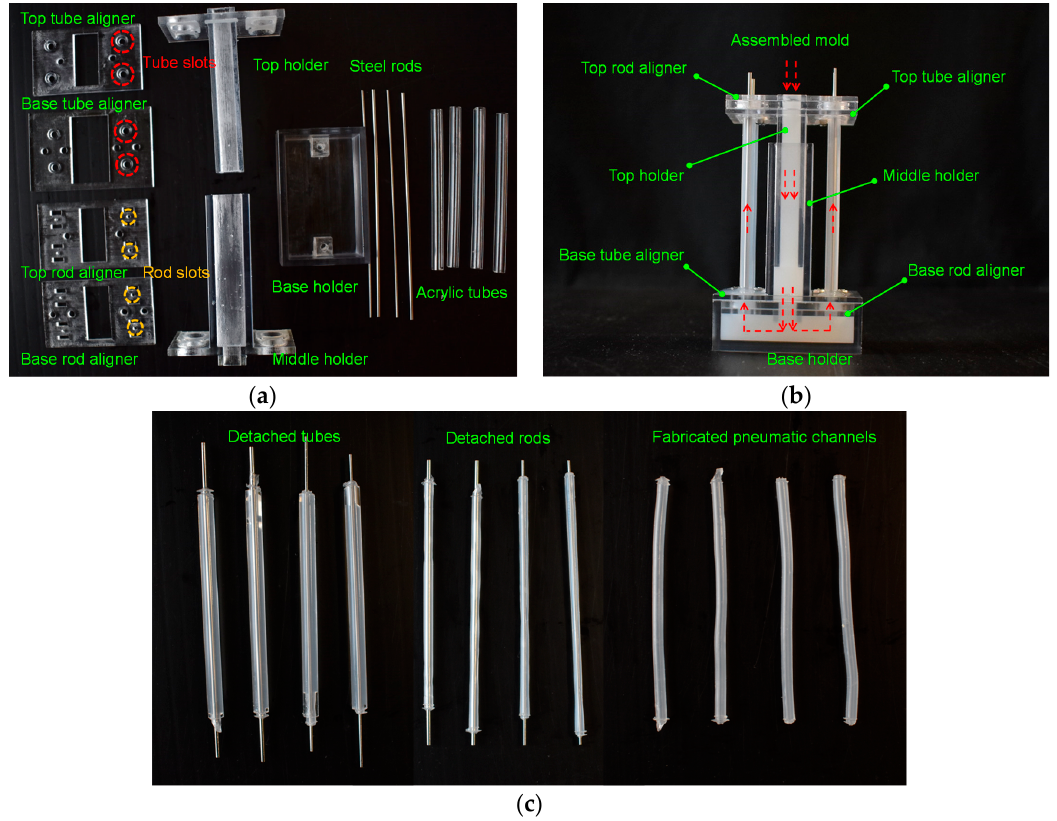
Figure 5. Fabrication procedures of the soft pneumatic channels: ( a ) the molds including holders, tube aligners, rod aligners, acrylic tubes, and steel rods; ( b ) the assembled mold; and ( c ) the detached tubes, detached steel rods, and the fabricated pneumatic channels.